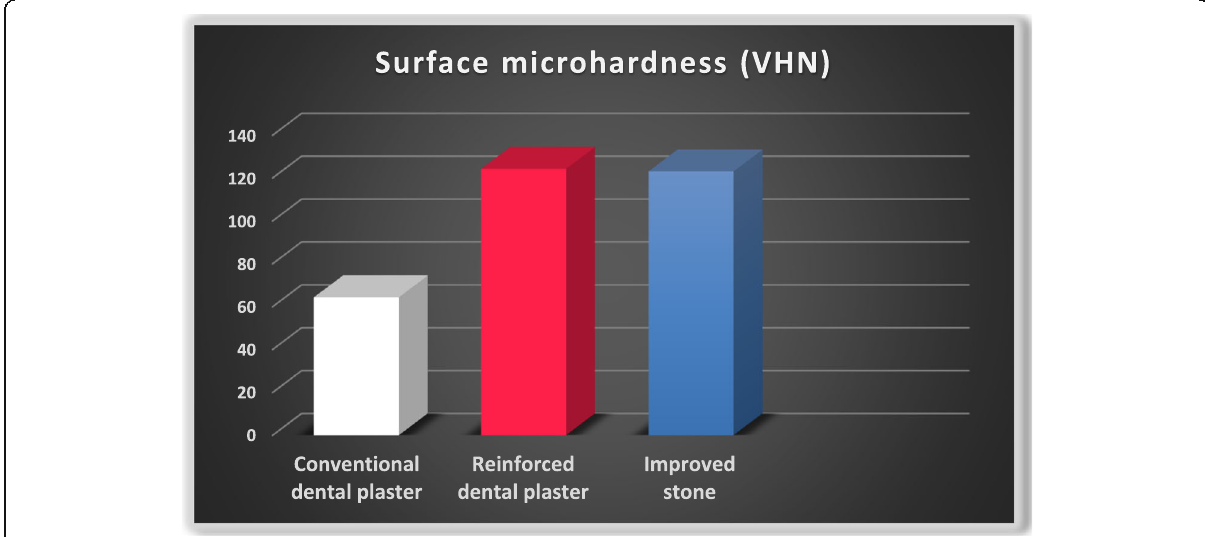
Fig. 4 Histogram demonstrating mean VHN between the three